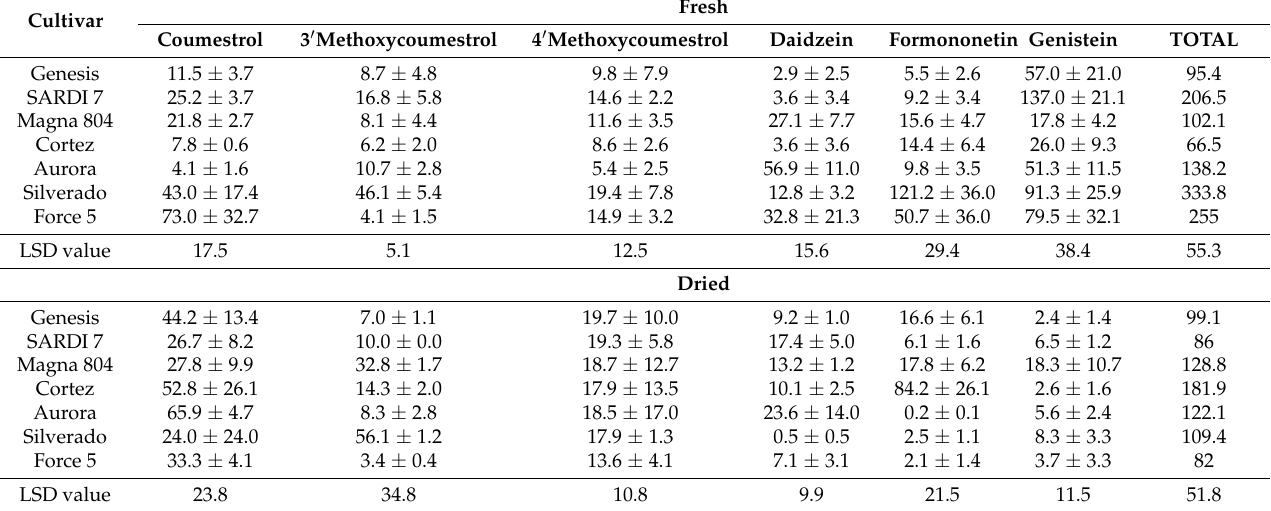
Table 1. The concentrations of most abundant coumestans and isoflavones identified in the lucerne cultivars grown under glasshouse conditions expressed in mg · kg − 1 of dry matter (DM). LSD values indicate significant differences among cultivars for each metabolite at p =